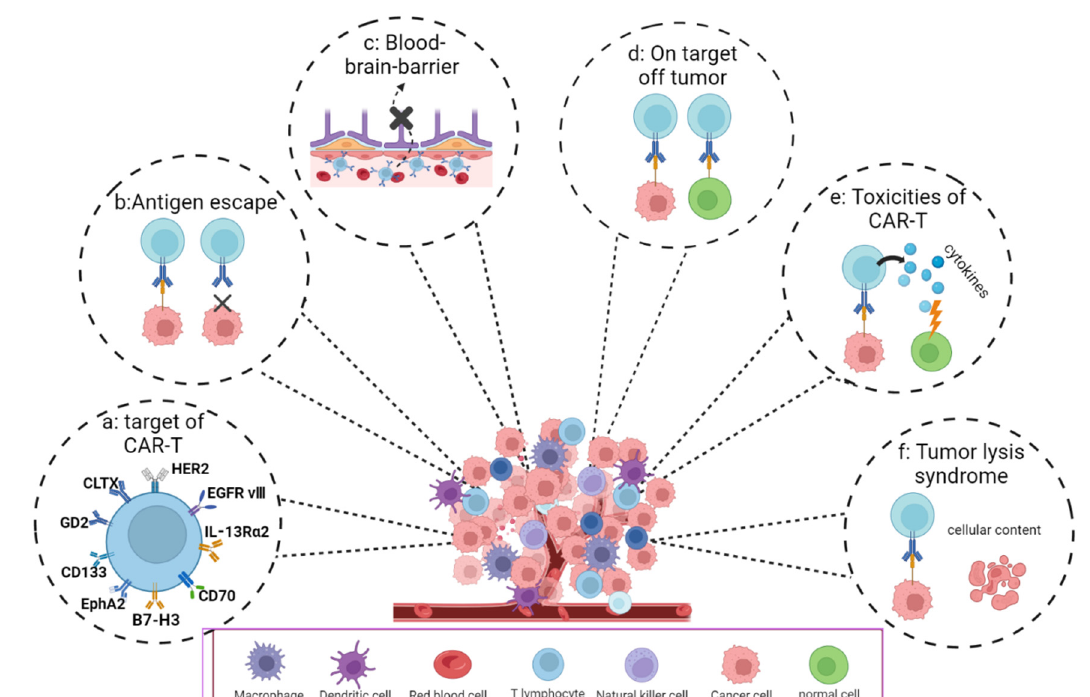
Figure 4. The di ffi culties and challenges of CAR-T cell therapy. ( a ) Gene targets of CAR-T. ( b ) Tumor heterogeneity and antigen escape. This is thought to be the underlying factor in drug resistance. ( c ) Several medications, including CAR-T, are prevented from entering the brain by the unique struc- ture of the blood–brain barrier (BBB). ( d ) O ff -target e ff ect: CAR-T can recognize not only tumor cells, but also antigens shared with tumor cells on normal tissue cells to a tt ack normal tissues and organs of the human body. ( e ) CAR-T cell-related toxicity, for example, cytokine release syndrome. ( f ) Tu- mor lysis syndrome (TLS). A large number of cancer cells that have been treated die in a short period of time and the cell contents are released into the bloodstream, leading to a variety of metabolic disorders.